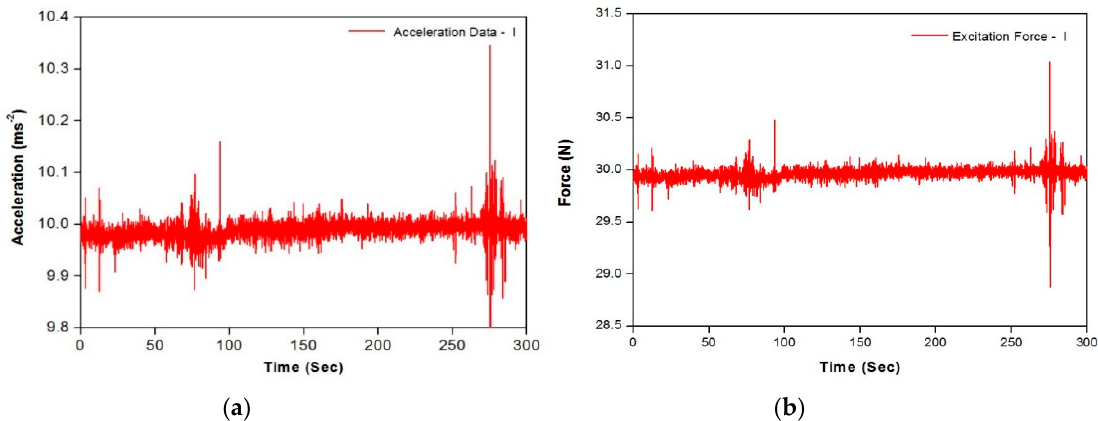
Figure 7. Input data for case I: ( a ) acceleration data; ( b ) excitation force.